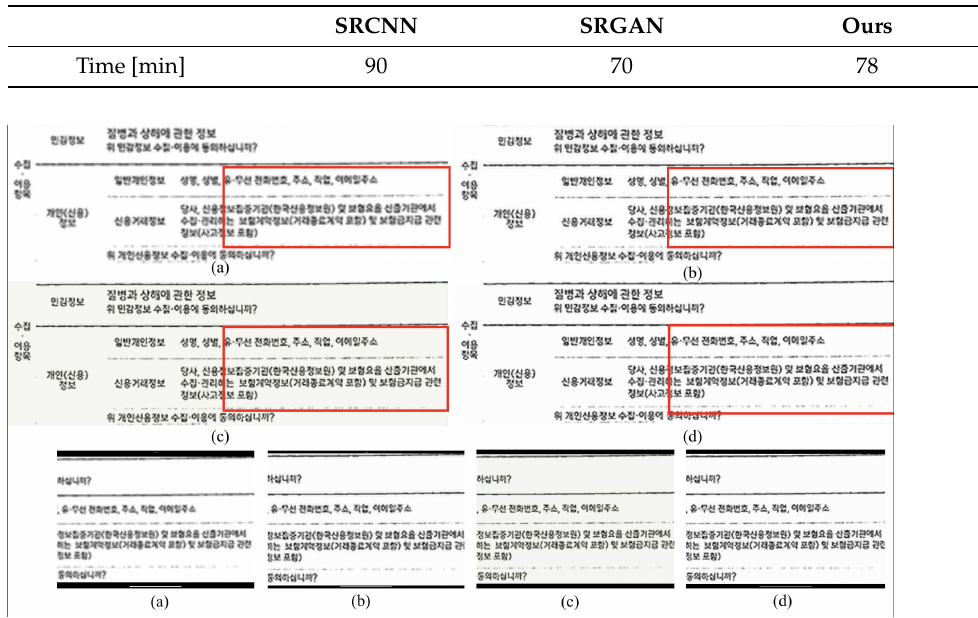
Table 2. Speed of each model: In the same environment, the proposed method has high-quality speed compared to ordinary methods.